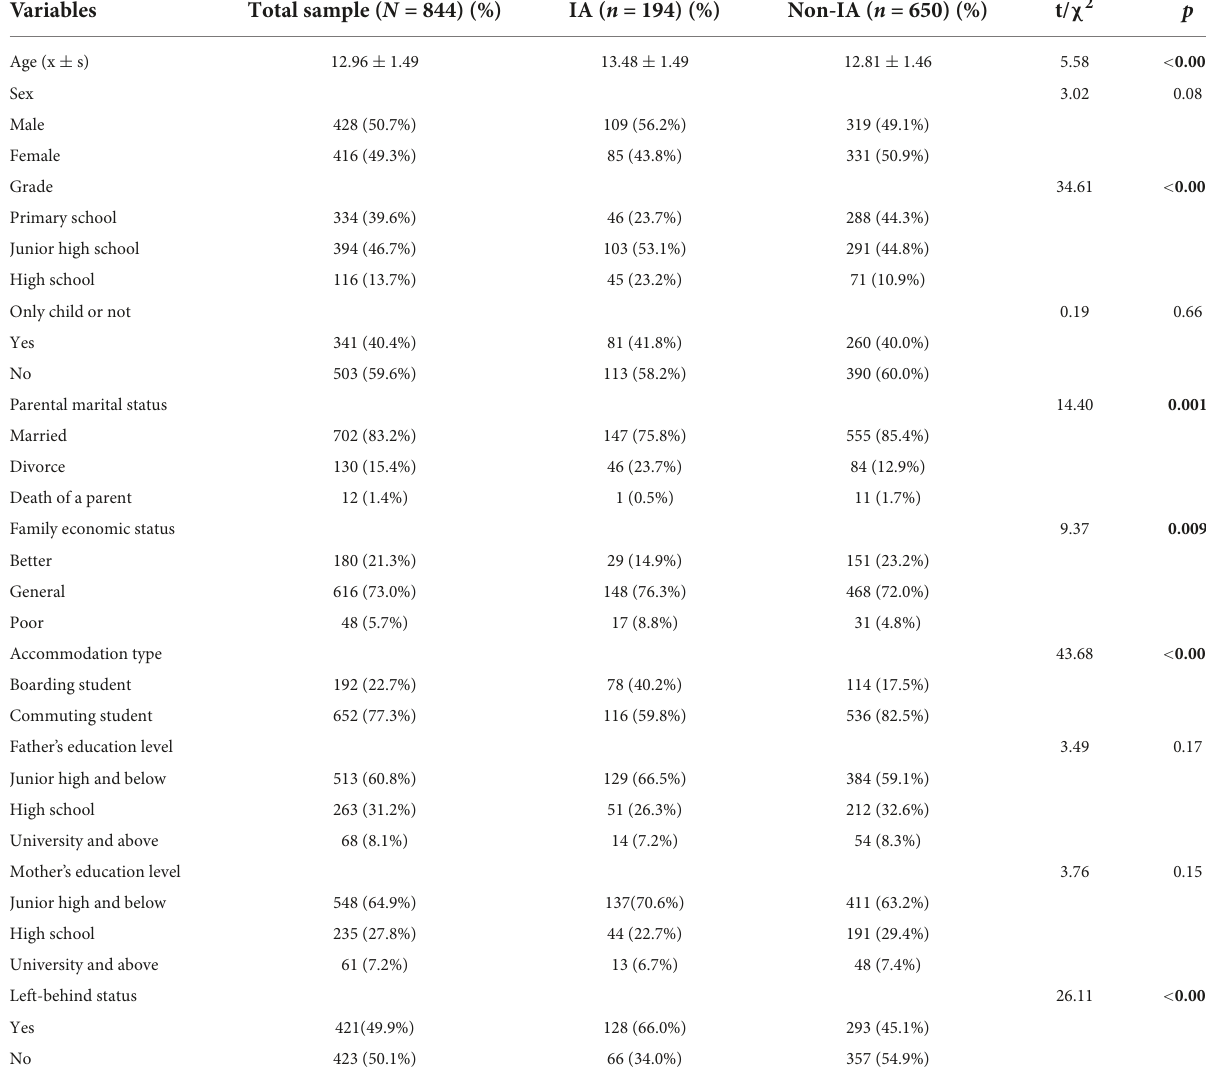
TABLE 1 Comparison of general sociodemographic data between the Internet addiction group and the non-Internet addiction group.